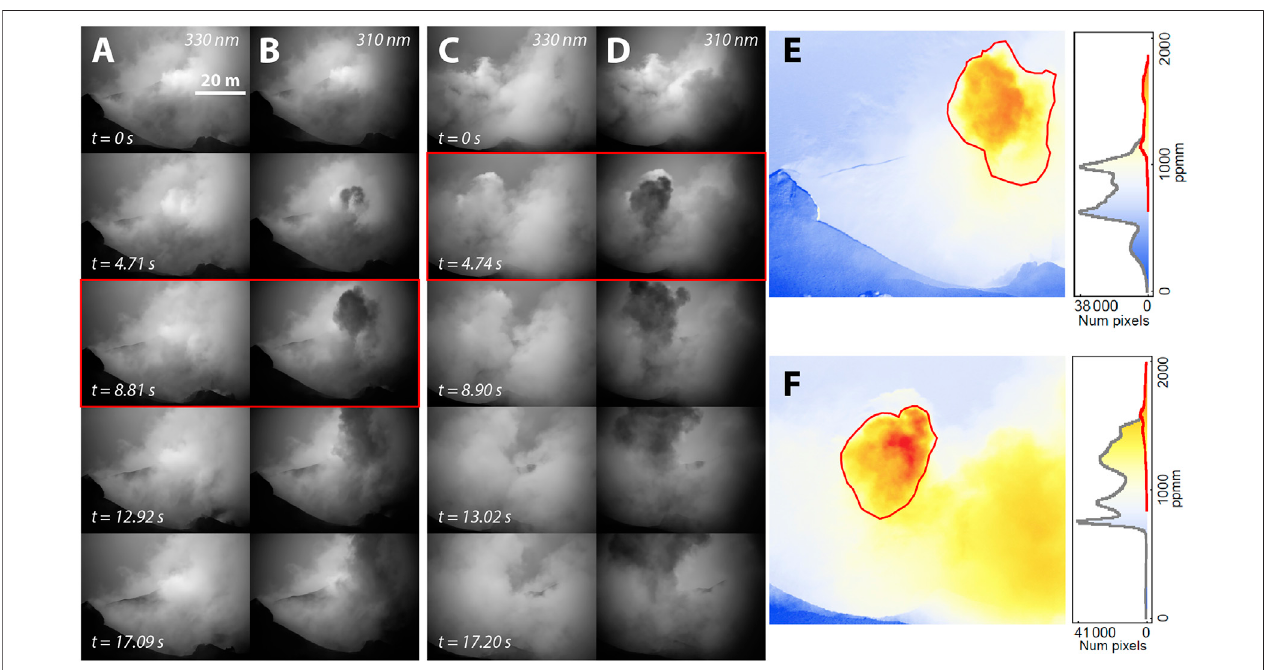
FIGURE6| SequencesofimagesofthetwoexploitableSO 2 plumesabovetheSouthWest(SW)crater,27July,recordedwiththeUltra-Violet(UV)SO 2 camera. (A, B) Plume recorded at 14:54. (C, D) Explosion recorded at 15:21. (A, C) are 330 nm images (no SO 2 absorption). (B, D) are 310 nm images (SO 2 absorption). The SO 2 plume is visible on the 310 nm images in black. Image pairs framed in red were chosen to calculate Apparent Absorption (AA) images and calibrated SO 2 images in ppmm that are represented in (E, F) for the 14:54 and 15:21 explosions, respectively. Eruption plumes are outlined in red. Histograms to the right of both images show the image (gray curve) and plume (red curve) ppmm distributions.